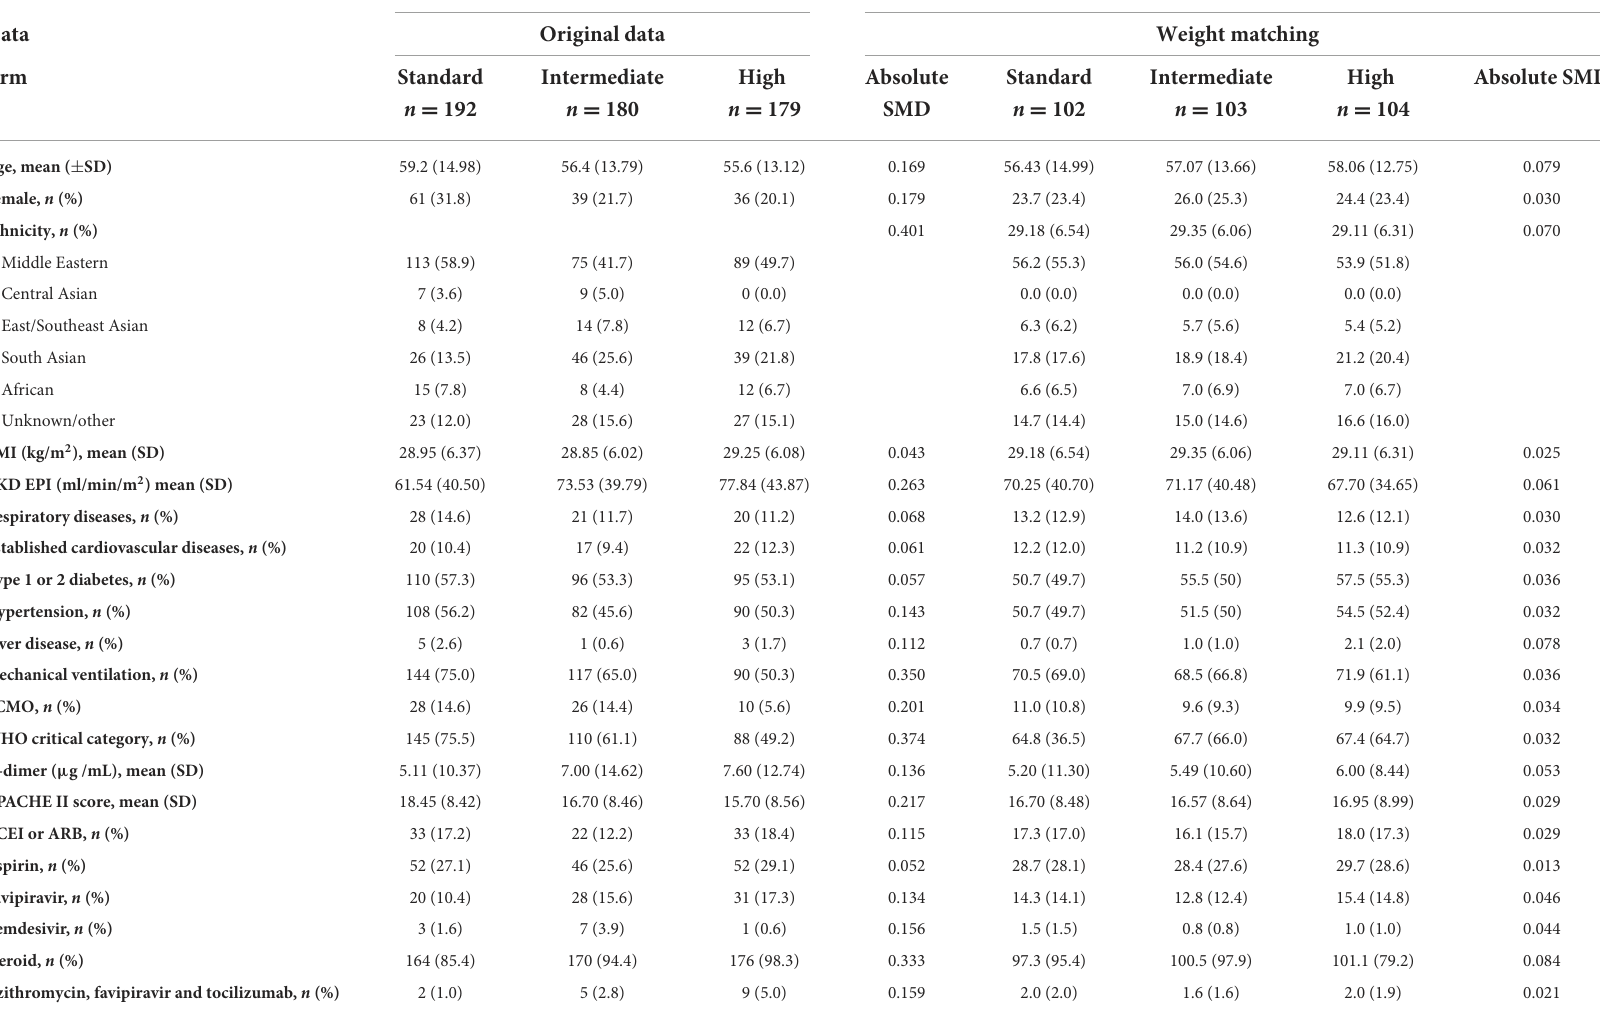
TABLE 2 Covariate balance post weight matching procedure and multiple imputations. Covariate Pre-covariate balance Post-covariate balance Data Original